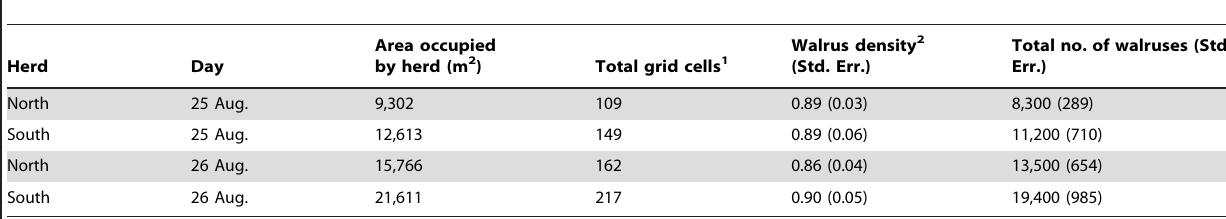
Table 5. Estimates of overall density and total number of walruses in herds hauled out on the northwest coast of Alaska in fall of